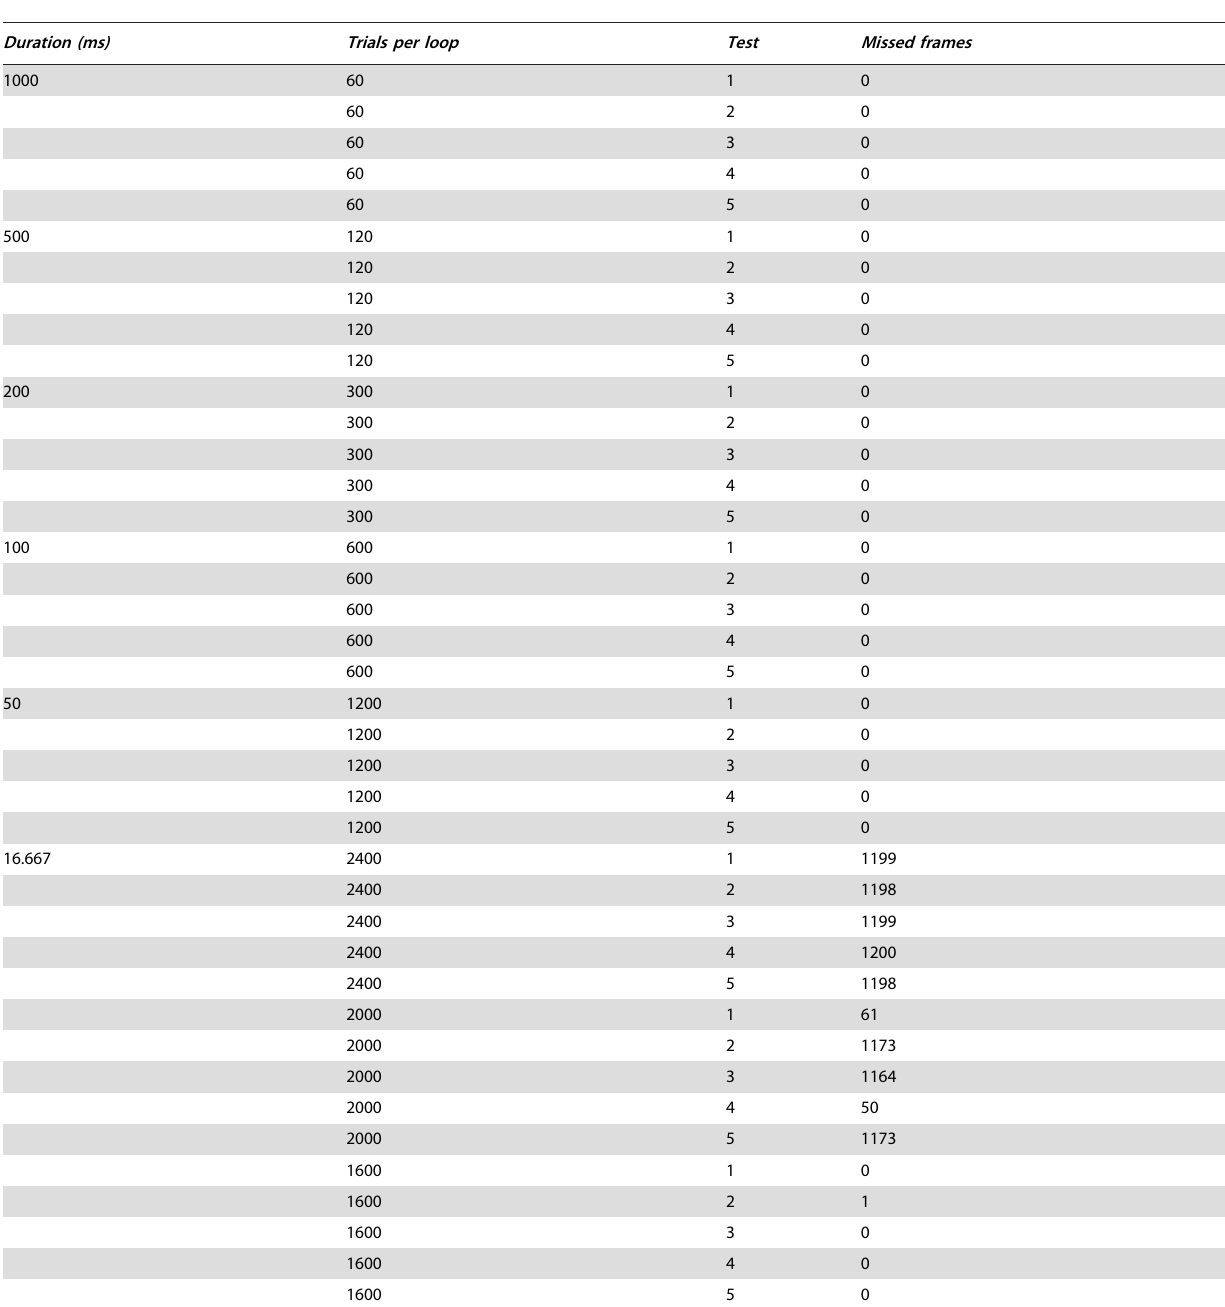
Table 1. PsychoPy 1.80 timing tests on MacBook Pro Late 2013 under MacOS X